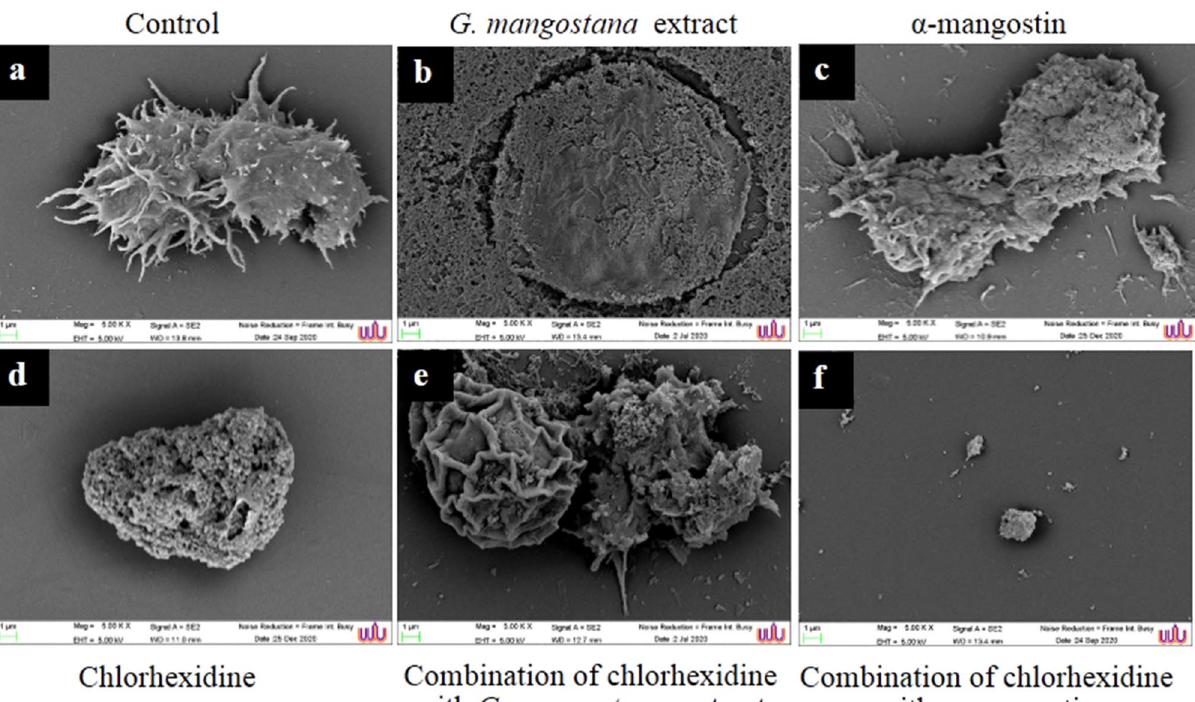
Figure 6. Scanning micrographs of A. triangularis trophozoites after treatment with G. mangostana extract, chlorhexidine, α-mangostin and in combination at 24 h. Control trophozoites ( a ), trophozoites treated with G . mangostana extract (1 mg/mL) ( b ), α-mangostin (0.5 mg/mL) ( c ), chlorhexidine (0.008 mg/mL) ( d ), and combination of chlorhexidine (0.004 mg/mL) and G. mangostana extract (0.125 mg/mL) ( e ), combination of chlorhexidine (0.002 mg/mL) and α-mangostin (0.032 mg/mL) ( f ). Magnification: ( a – f ) = ×